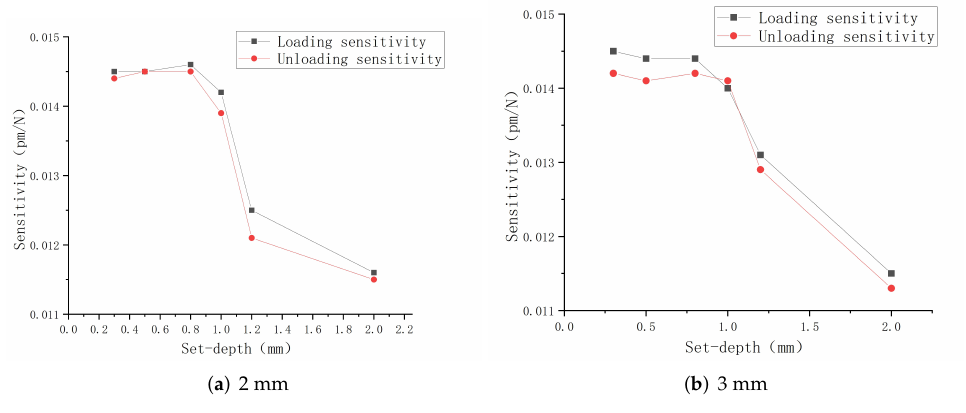
Figure 10. FBG linear sensitivity